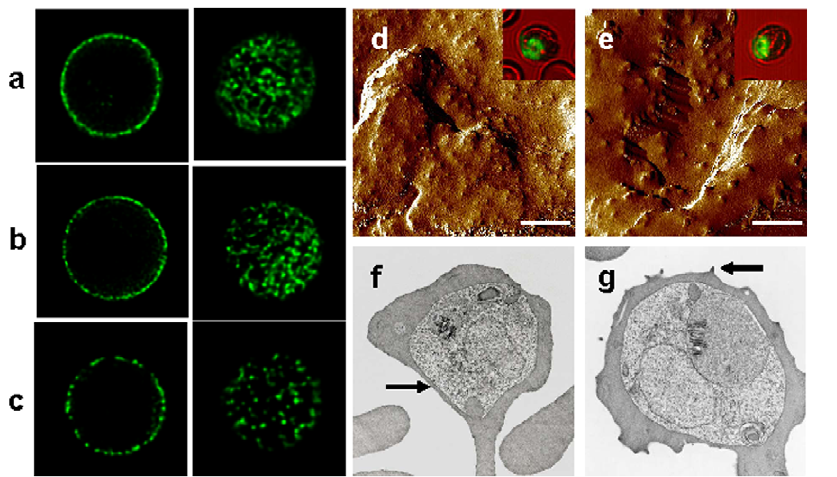
Figure 3. Distributions of PfEMP-1 signals and knobs on the surface of parasitized AA and CB RBCs. a–c , Confocal cross-sections through the mid-plane (left column) or maximum intensity projections of z stacks through the upper cell surface (right column) of trophozoite- infected RBCs probed with a polyclonal antiserum against PfEMP-1 (FVO line). a , PfEMP-1 fluorescence patterns typical of a parasitized AA RBC. b , Fluorescence patterns from a parasitized CB RBC, similar to those of parasitized AA RBCs. c , Irregular, patchy PfEMP-1 distribution on a parasitized CB RBC. d,e , Atomic force micrographs of CB RBCs infected with the FVO P. falciparum line, showing normal AA-like ( d ) or abnormal ( e ) knob appearances. The mean ( 6 SEM) width of 15 randomly selected knobs in panels d and e were 50.3 nm ( 6 3.4 nm) and 96.4 nm ( 6 6.7 nm), respectively. Scale bar =1 m m. Transmission electron micrographs of CB RBCs infected with the FVO P. falciparum line also showed populations with normal ( f ) or abnormal ( g ) knob appearances. Comparison atomic force and transmission electron micrographs of parasitized HbC and HbS RBCs can be found in references 9, 10, and 11. Arrows indicate examples of normal ( f ) and abnormal ( g ) knobs.